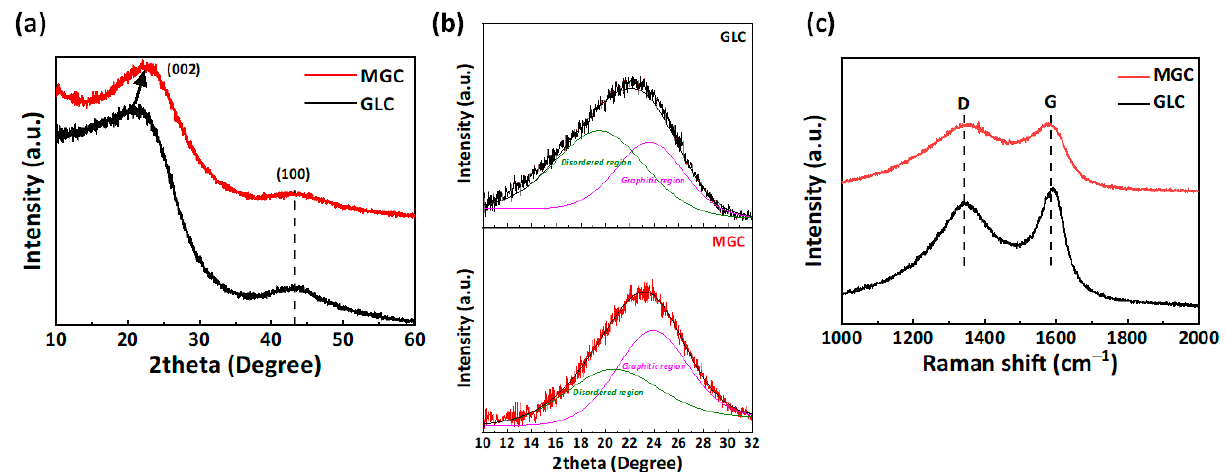
Figure 2. ( a ) XRD patterns of GLC and MGC, ( b ) deconvolution of the (002) peaks of GLC and MGC XRD patterns, and ( c ) Raman spectra of GLC and MGC. Table 1. Crystal structure of GLC and MGC; interlayer space, Lc, La, stacking number, R factor, and I G /I D . Materials